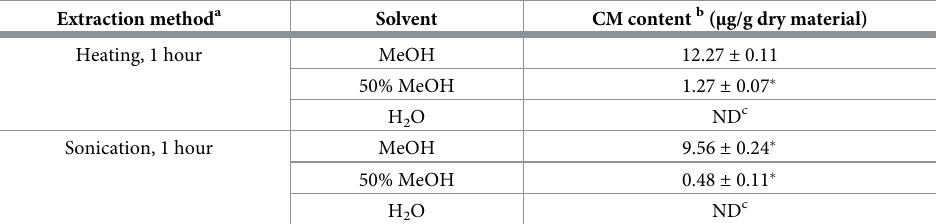
Table 1. CM content of soybean sprout hypocotyls extracted using three solvent systems (water, 50% MeOH, or MeOH) and two conditions (heating at 50˚C for 1 h or sonication for 1 h).